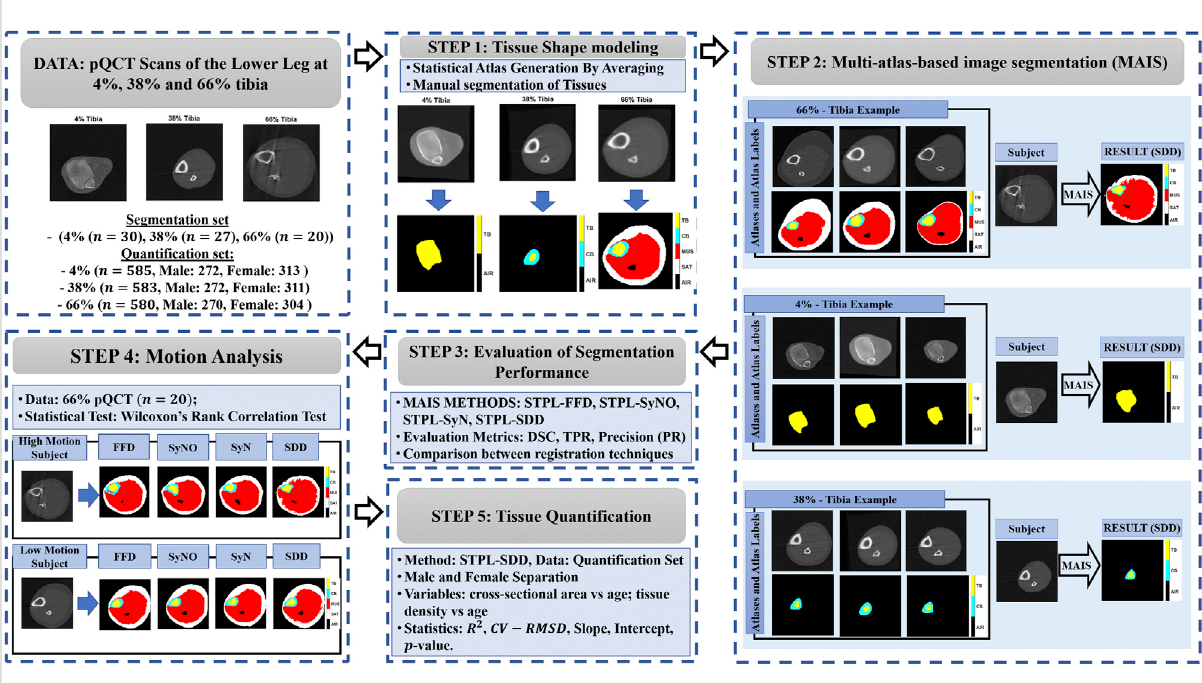
FIGURE 1 Main components of the proposed framework. STAPLE (STPL), free-form deformation (FFD), symmetric diffeomorphic demons (SDD), symmetric normalization (SyN), symmetric normalization - only (SyNO), dice similarity coef fi cient (DSC), true positive rate (TPR), precision (PR) squared-Spearman ’ s correlation coef fi cient ( R 2 ), and coef fi cient of variation - root mean squared difference (CV-RMSD).